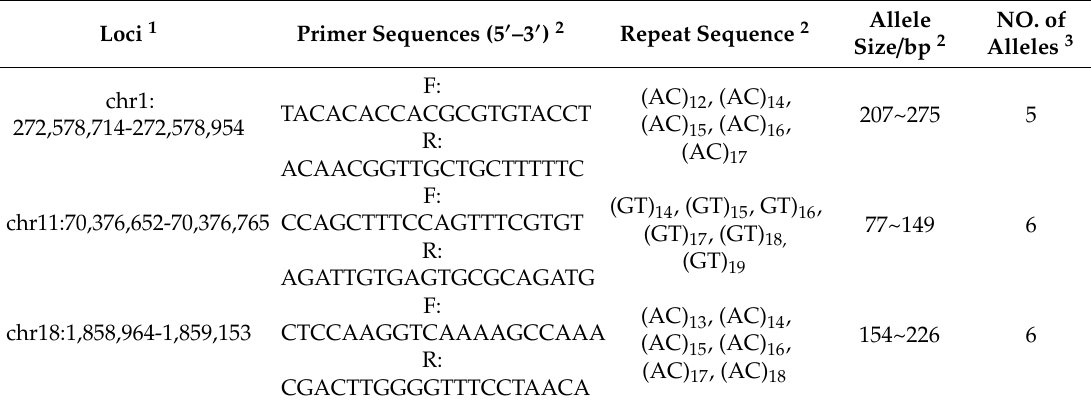
Table 4. Information and validation of 3 SSRs in 60